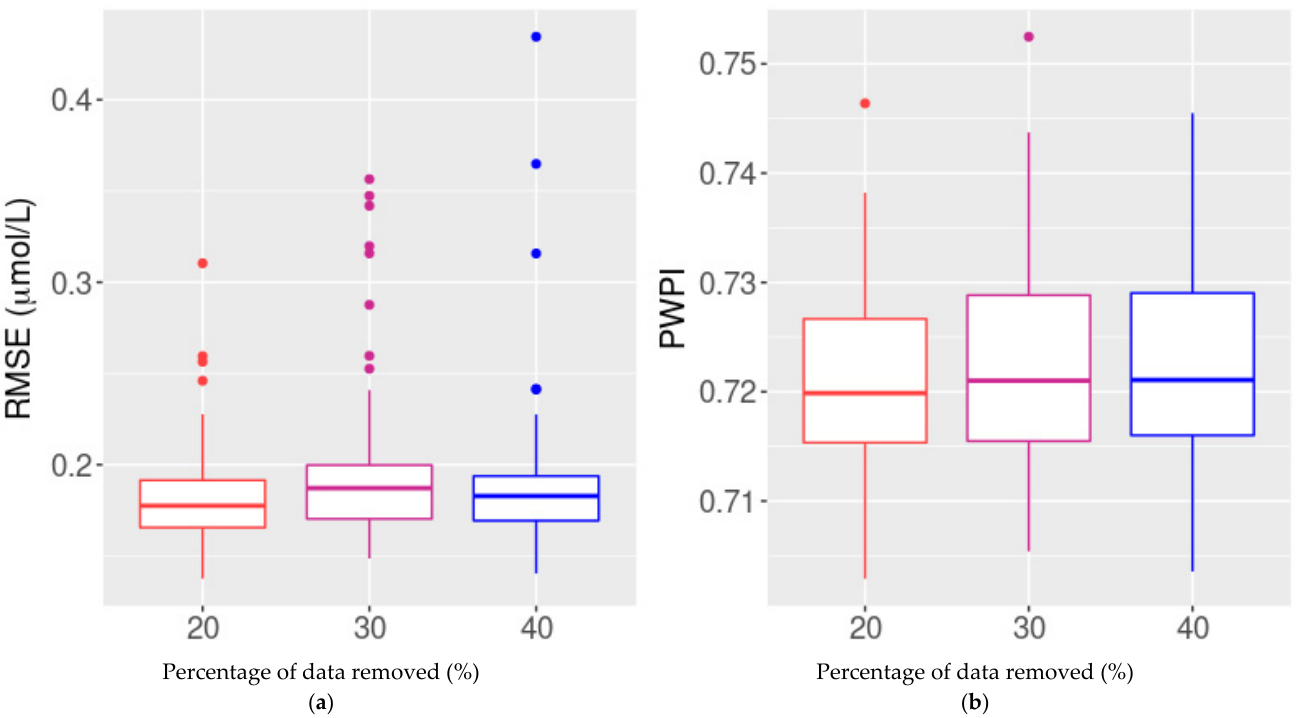
Figure 4. Performance evaluation: reconstructing missing point data. Boxplots of ( a ) root-mean-square error (RMSE) and ( b ) the proportion of reconstructed data within the precision interval (PWPI) for different amounts of randomly removed point observations, simulated 100 times.